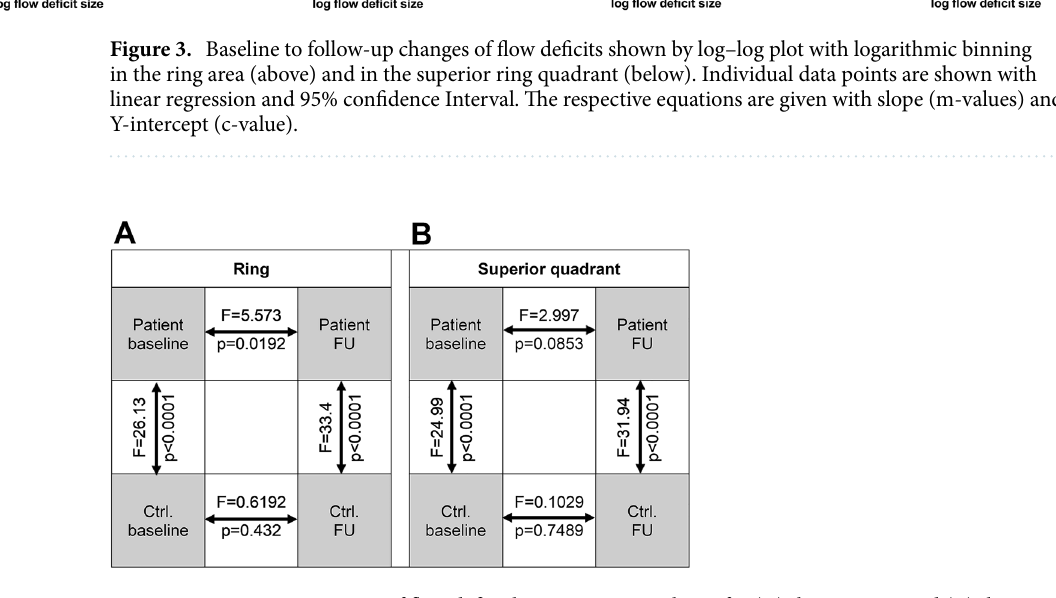
Figure 4. Comparison matrix of flow deficit linear regression slopes for ( A ) the ring area and ( B ) the superior ring quadrant. Arrows indicate respective comparisons with p and F values (derived from F tests). Ctrl control, FU